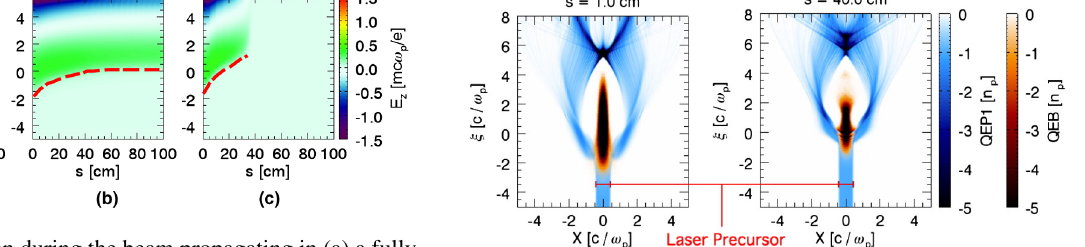
brown.FIG. 6. E z evolution during the beam propagating in (a) a fully preformed plasma; (b) a field-ionized Li plasma with the narrow plasma filament; (c) a field-ionized Li plasma. The Gaussian beam suffers little head erosion in a preformed plasma but rapidly erodes in the field-ionized